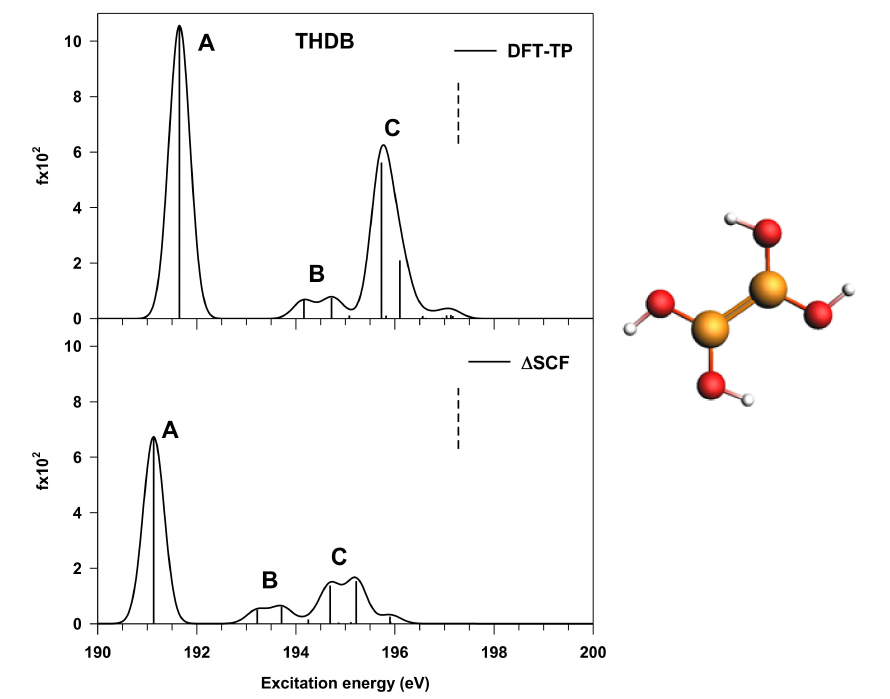
Figure 2. Calculated B K-edge NEXAFS spectrum of THDB (reported on the right side). ( Upper panel ): DFT-TP results; ( lower panel ): ∆ SCF results. The stick spectra are broadened by using a Gaussian line shape with FWHM = 0.5 eV. ∆ SCF B1s IP (197.28 eV) is reported as a vertical dashed line.